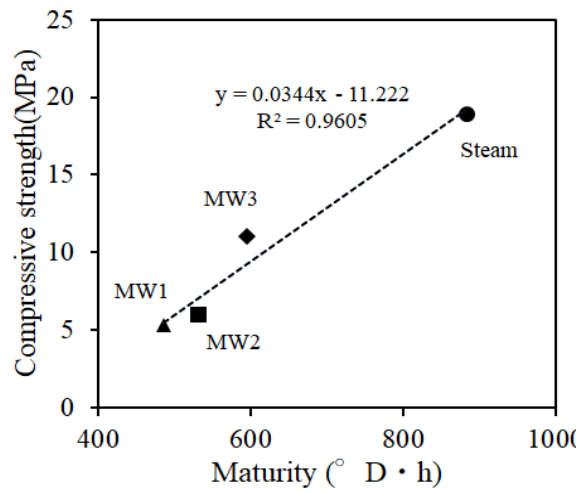
Figure 13. Relation between compressive core strength and maturity.